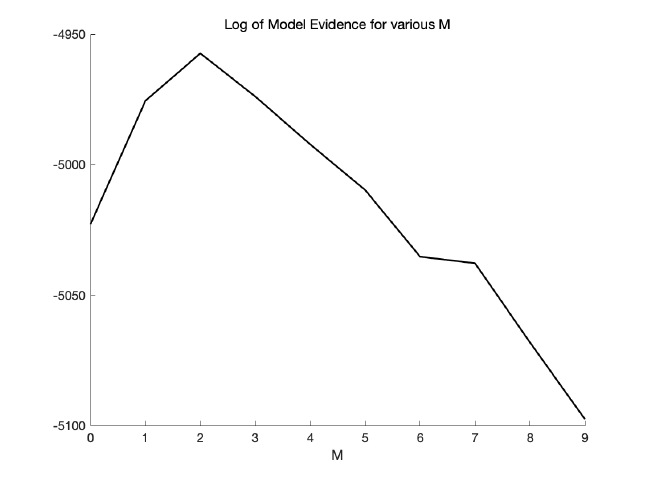
Figure 6. Plot of a model evidence for various values of